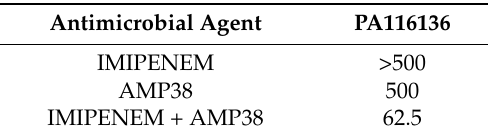
Table 3. Minimal biofilm eradication concentration (MBEC) of imipenem, AMP38, and the combination of both antimicrobials ( µ g/mL).